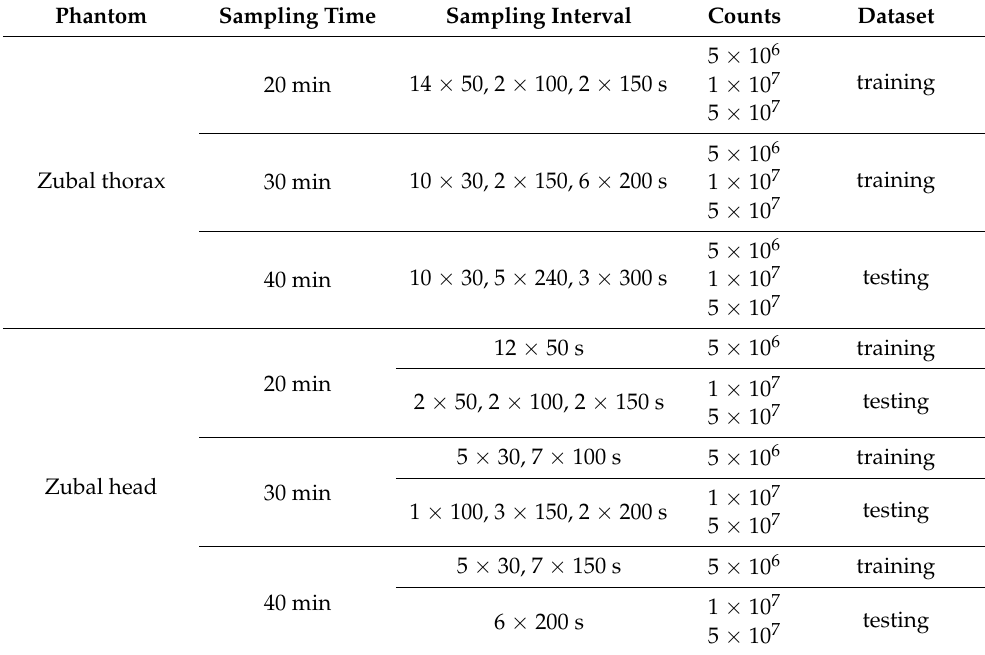
Table 1. Dataset for simulation experiments.